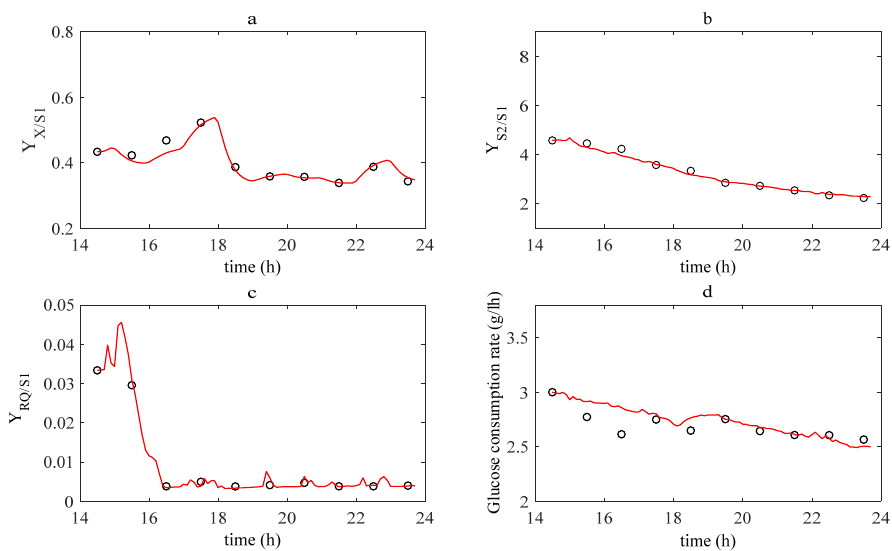
; ( b ): yield coe ffi cient Y S ; ( c ): yield coe ffi cient 1 2 / S 1